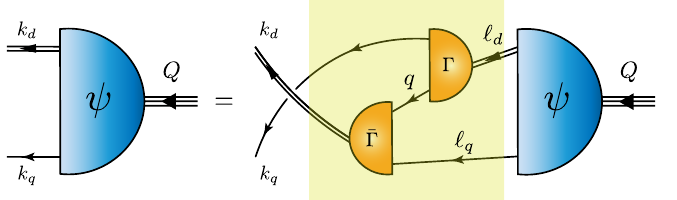
Figure 8. Figurative representation of the integral equation satisfied by the Poincaré-covariant matrix- valued function Ψ , viz. the Faddeev amplitude for a baryon with total momentum Q = (cid:96) q + (cid:96) d = k q + k d built from three valence quarks, two of which are always participants in a nonpointlike, interacting diquark correlation. Ψ describes the sharing of relative momentum between the dressed quarks and diquarks. Shaded rectangle —Faddeev kernel. Legend: single line —dressed quark propagator, S ( q ) ; Γ J P ( k ; K ) —diquark correlation amplitude; double line —diquark propagator, ∆ J P ( K ) .